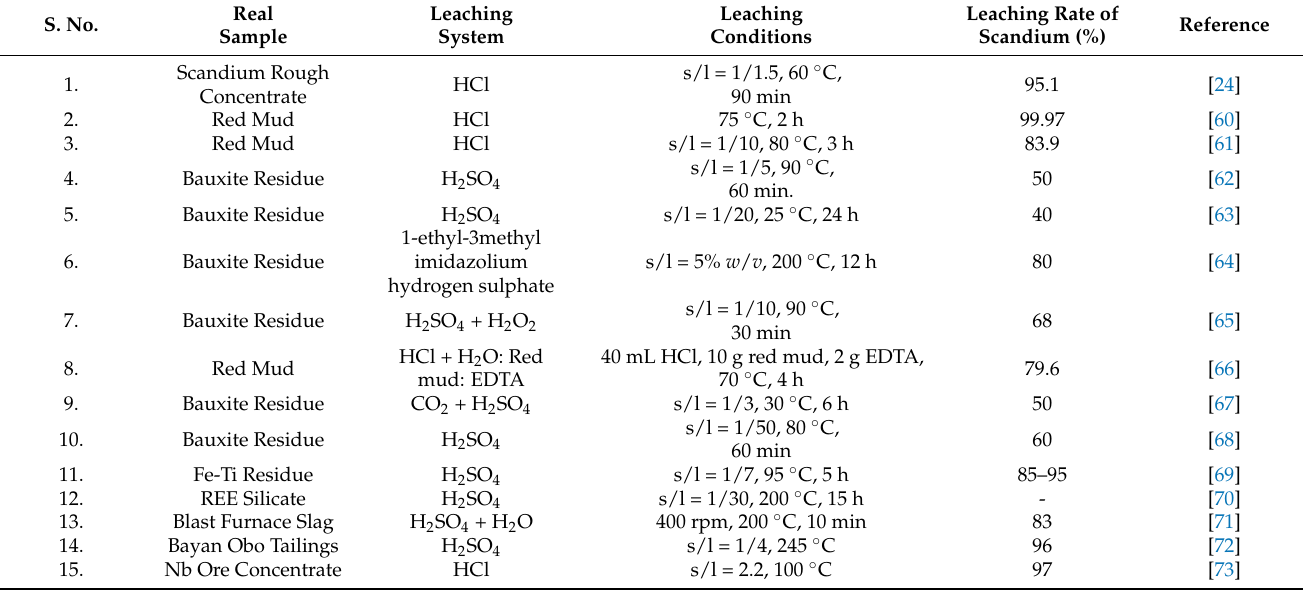
Table 3. A brief summary of different systems of scandium leaching from secondary